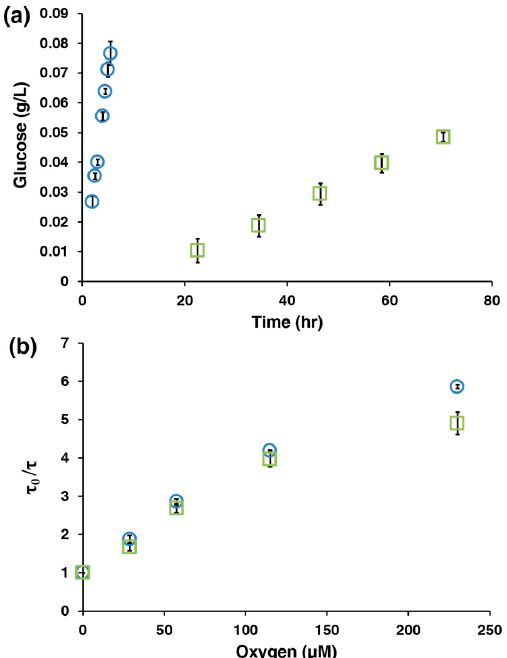
Figure 2. ( a ) Plot showing the difference in the rate of glucose permeation through 10 bilayers of PAH/PSS without (blue ○ ) and with (green □ ) glutaraldehyde crosslinking; ( b ) The phosphorescence lifetimes of AnA hydrogels containing 10 bilayers of PAH/PSS plotted against the oxygen concentrations for particles without (blue ○ ) and with (green □ ) glutaraldehyde crosslinking. Error bars for both plots represent 95% confidence intervals for three separate samples.